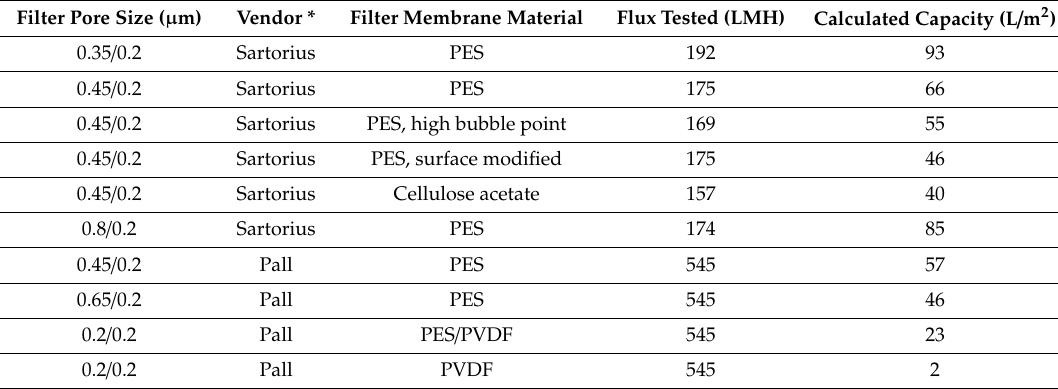
Table 6. Evaluation of filter capacity regarding 30% v / v